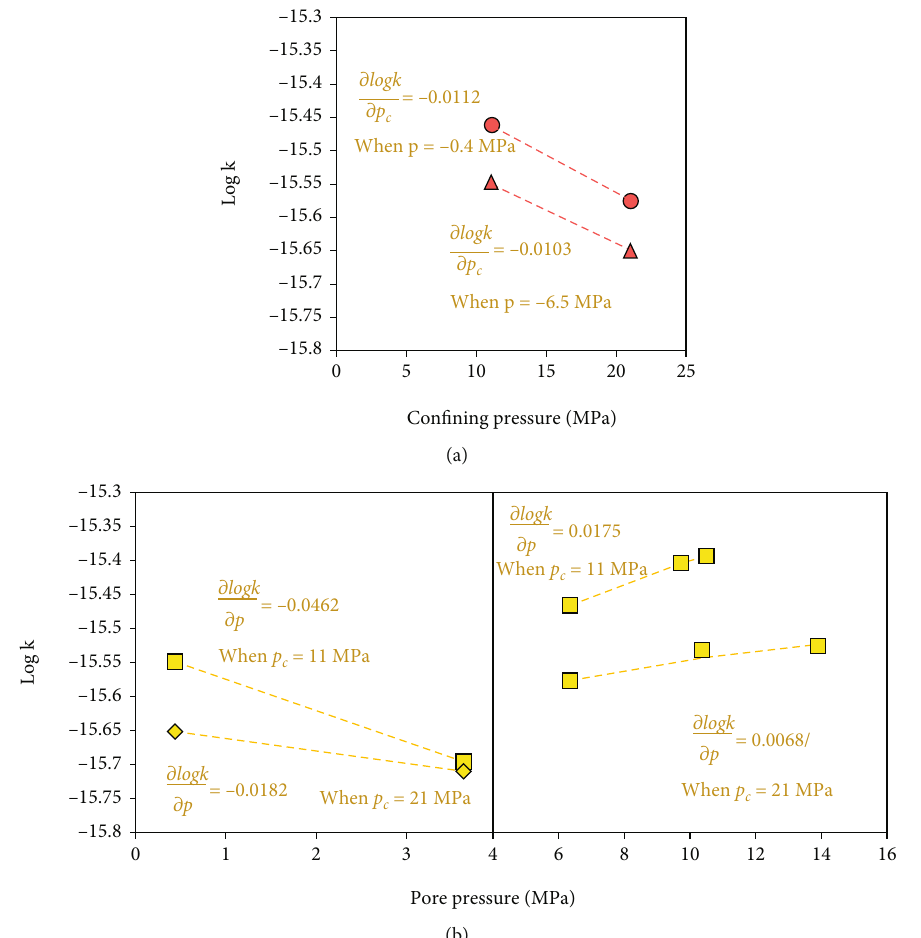
Figure 8: (a) CO permeability data of a 3.71mm shale disk linearized by plotting a logarithm of permeability versus con fi ning pressures at 2 constant pore pressures to determine the sensitivity of con fi ning pressure to permeability. (b) CO linearized by plotting a logarithm of permeability versus p at constant con fi ning pressures to determine the sensitivity of pore pressure to permeability. The slopes are positive when pressures are above ~ 4MPa and negative when below ~